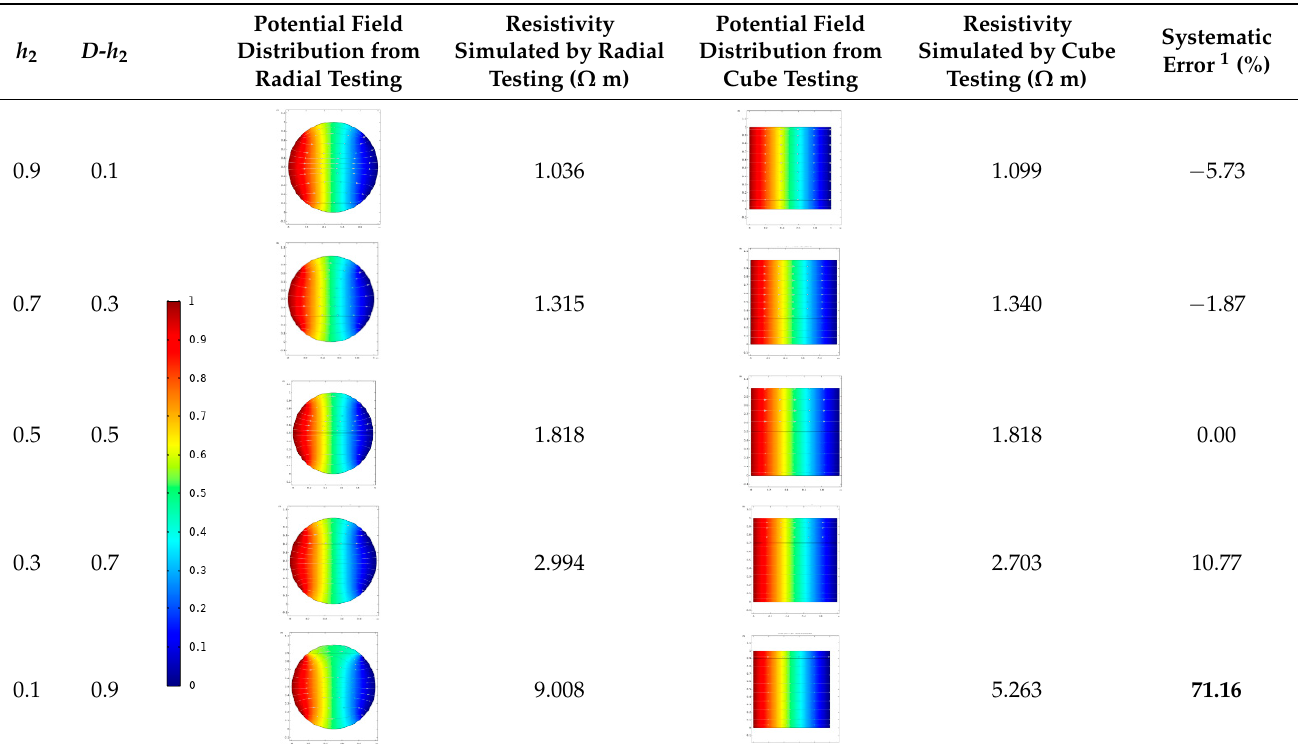
Table 1. Extreme 2: numerical simulation results of different material thicknesses.